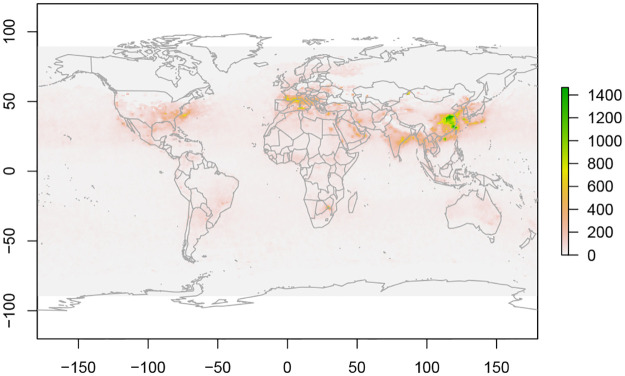
NO2 data from March 2018.